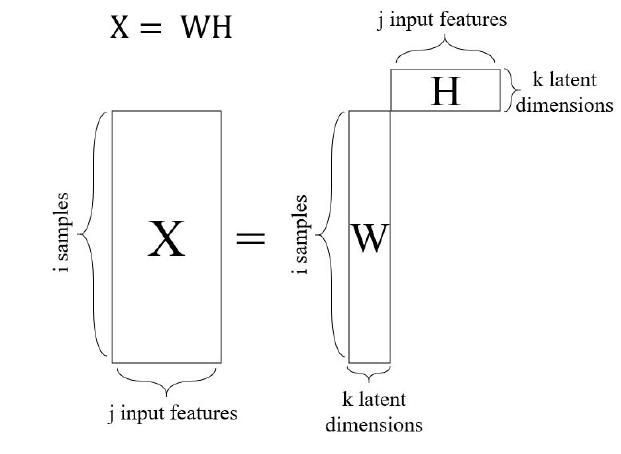
Figure 11. Non-negative matrix factorization.